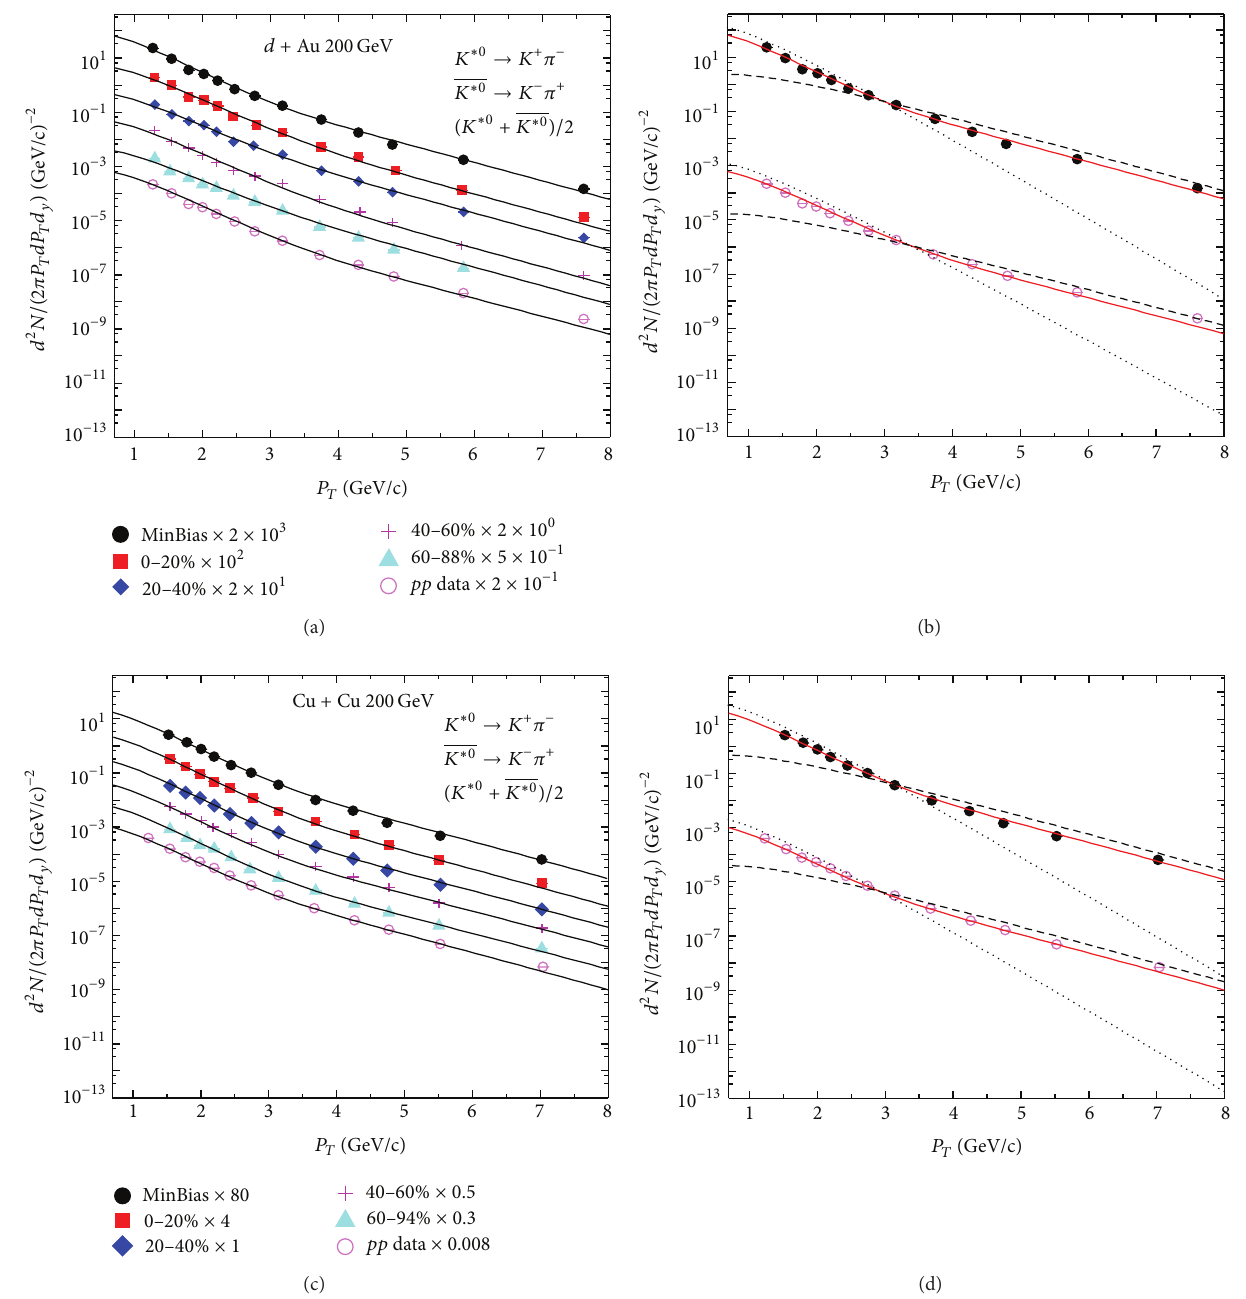
Figure 4: The same as Figure 2, but the solid lines are the results of (9). The dashed lines and the dotted lines denote the contributions of the first component and the second component,